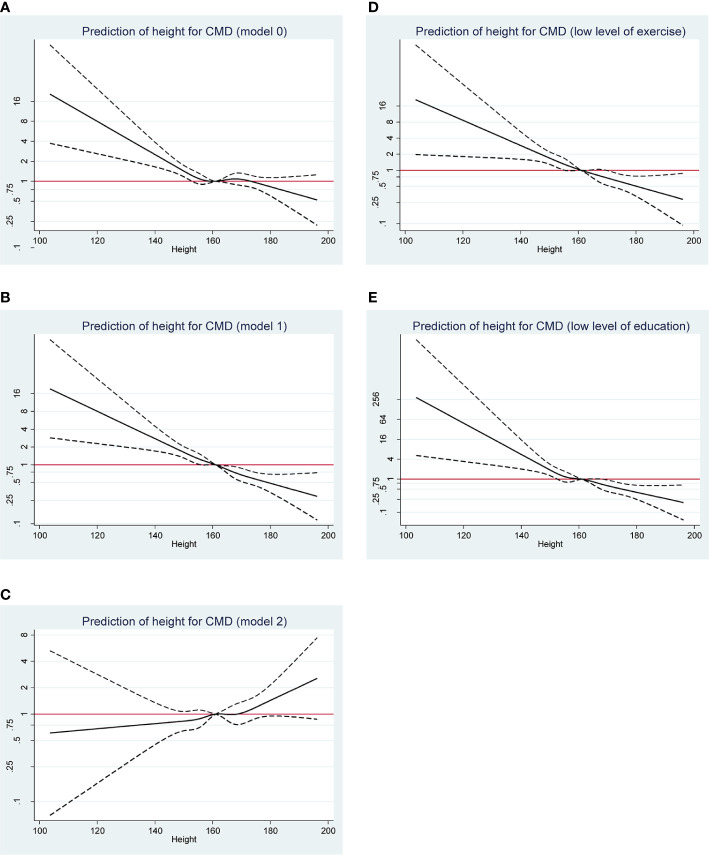
Restricted cubic spline regression analysis on the prediction of body height on a continuous scale for overall CMD risk under the model 0 (A), model 1 (B), and model 2 (C), respectively. Further analyses targeting participants with ≤3 times of exercise per week (D) or with education of secondary school degree or below (E). CMD, cardiometabolic disease. Under the model 0, no confounder was adjusted. Under the model 1, age, sex, marital status, personal income, drinking, and family histories of CMD were adjusted, and exercise and education were additionally adjusted under the model 2.